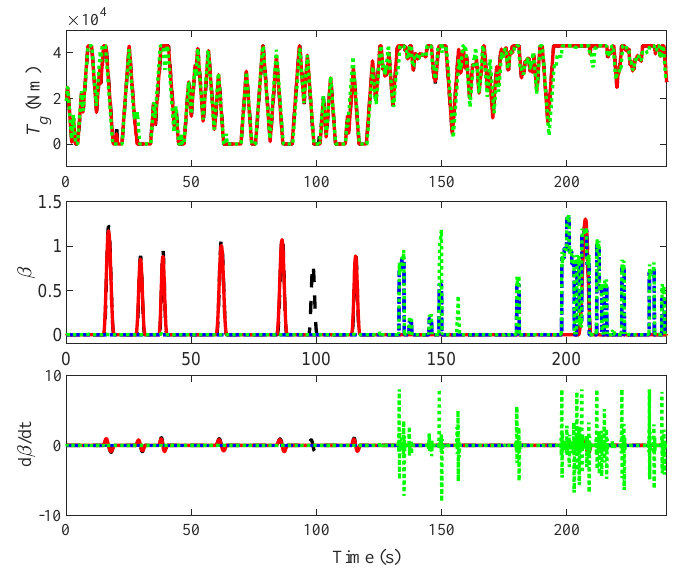
Figure 13. States T g , β and d β / dt for the proposed EMPC 1 (black dash-dotted line), EMPC 2 (red solid line) and classical tracking MPC (green dashed line) under turbulent